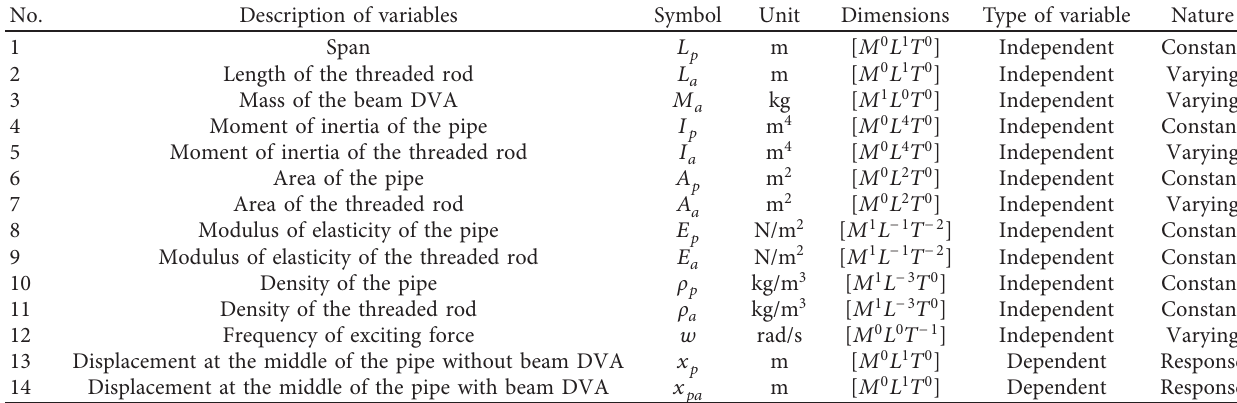
Table 4: List of π